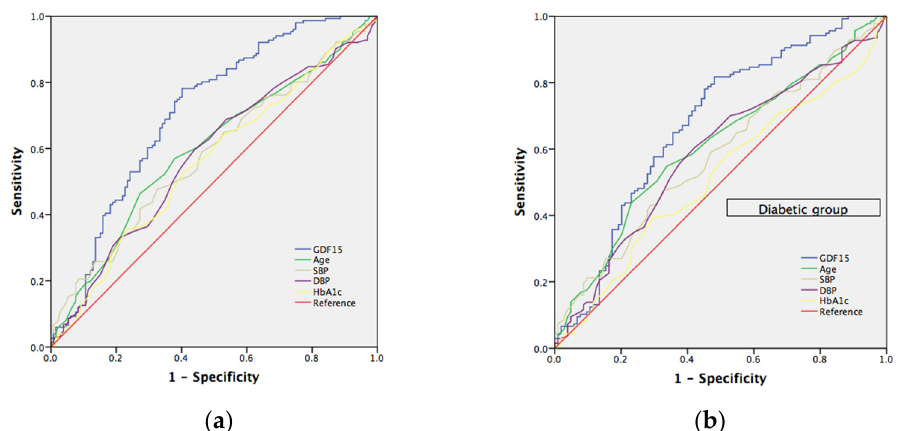
Figure 1. ( a ) Receiver operating characteristic (ROC) curves and area under the curve (AUC) in predicting chronic kidney disease. Blue line: GDF15 risk score (AUC = 0.709; p < 0.001); green line: age risk model (AUC = 0.597; p = 0.005); yellowish-green line: systolic blood pressure risk model (AUC = 0.582; p = 0.018); purple line: diastolic blood pressure risk model (AUC = 0.577; p = 0.025). yellowish line: HbA1c risk model (AUC = 0.560; p = 0.080). The red line represents the reference line. ( b ) Receiver operating characteristic (ROC) curves and area under the curve (AUC) in predicting chronic kidney disease in diabetic group. Blue line: GDF15 risk score (AUC = 0.676; p < 0.001); green line: age risk model (AUC = 0.609; p = 0.004); yellowish-green line: systolic blood pressure risk model (AUC = 0.580; p = 0.034); purple line: diastolic blood pressure risk model (AUC = 0.589; p = 0.019). yellowish line: HbA1c risk model (AUC = 0.515; p = 0.697). The red line represents the reference line. Table 3. Comparisons between high and low GDF